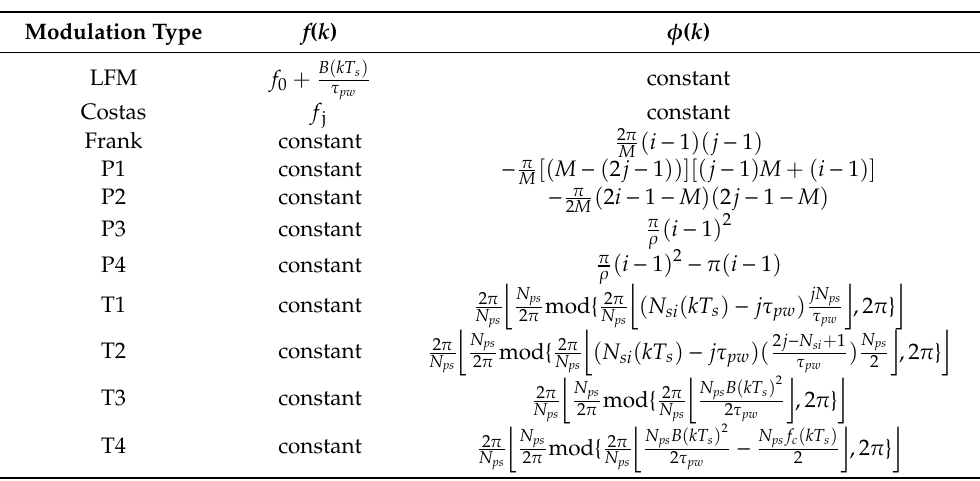
Table 1. Phase modulation signal